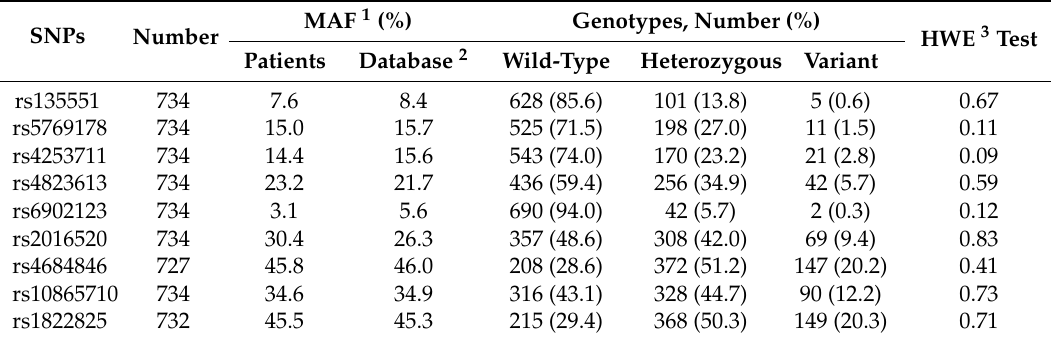
Table 2. Distribution of the nine genotyped SNPs in trauma patients.